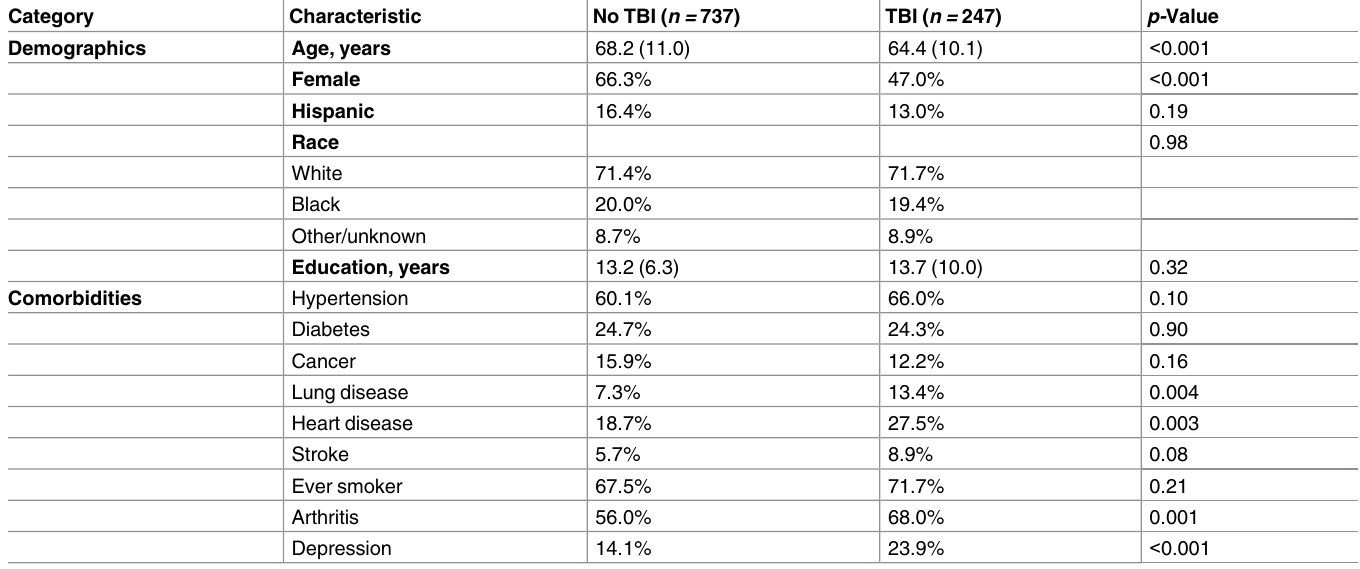
Values are mean (standard deviation) or percent. TBI, traumatic brain injury.